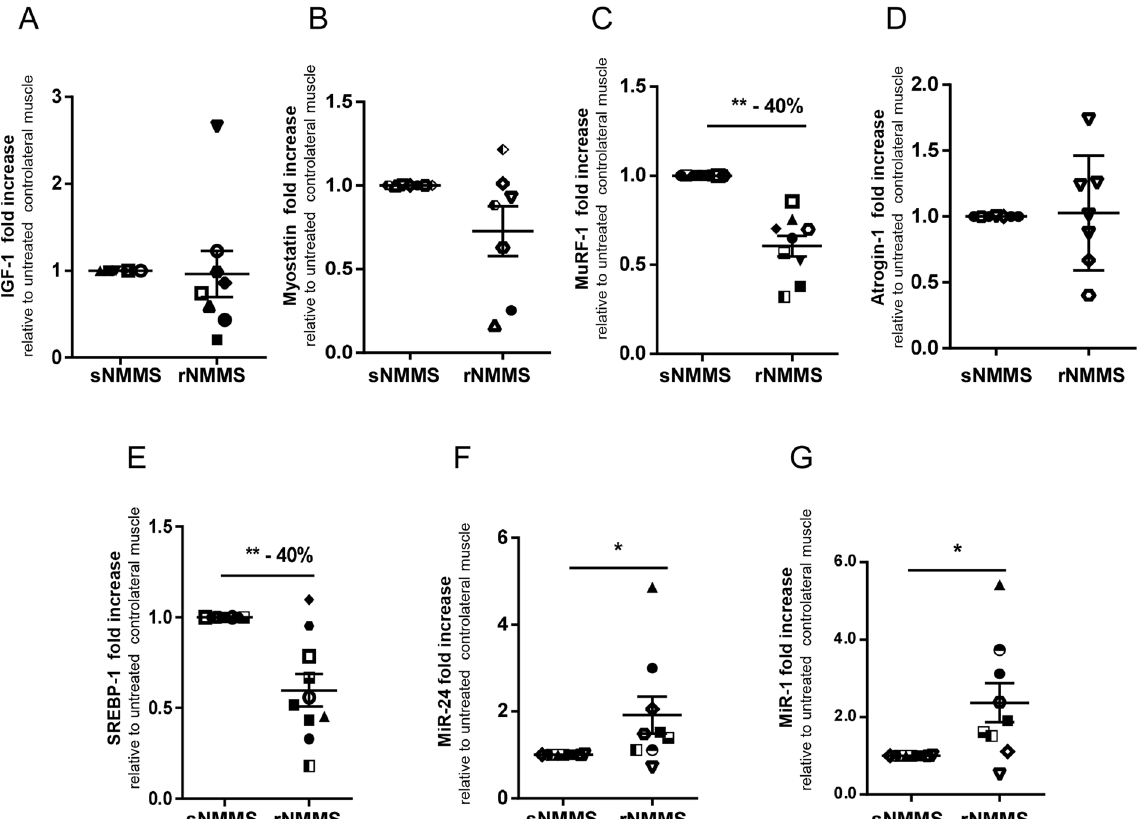
Figure 6. NMMS treatment counteracts muscle atrophy and enhances robustness and resistance to fibrosis in ALS muscles. ( A ) Real-time PCR analysis of IGF-1EA, ( B ) myostatin, ( C ) MuRF-1, ( D ) atrogin-1, ( E ) SREBP-1, ( F ) MiR-24, ( G ) MiR-1 transcript in rNMMS- and sNMMS-treated samples ( ** p < 0.01, * p < 0.05. The number above the graph indicates the percentage decrease in transcript expression in treated vs control samples. Data are represented as mean ±